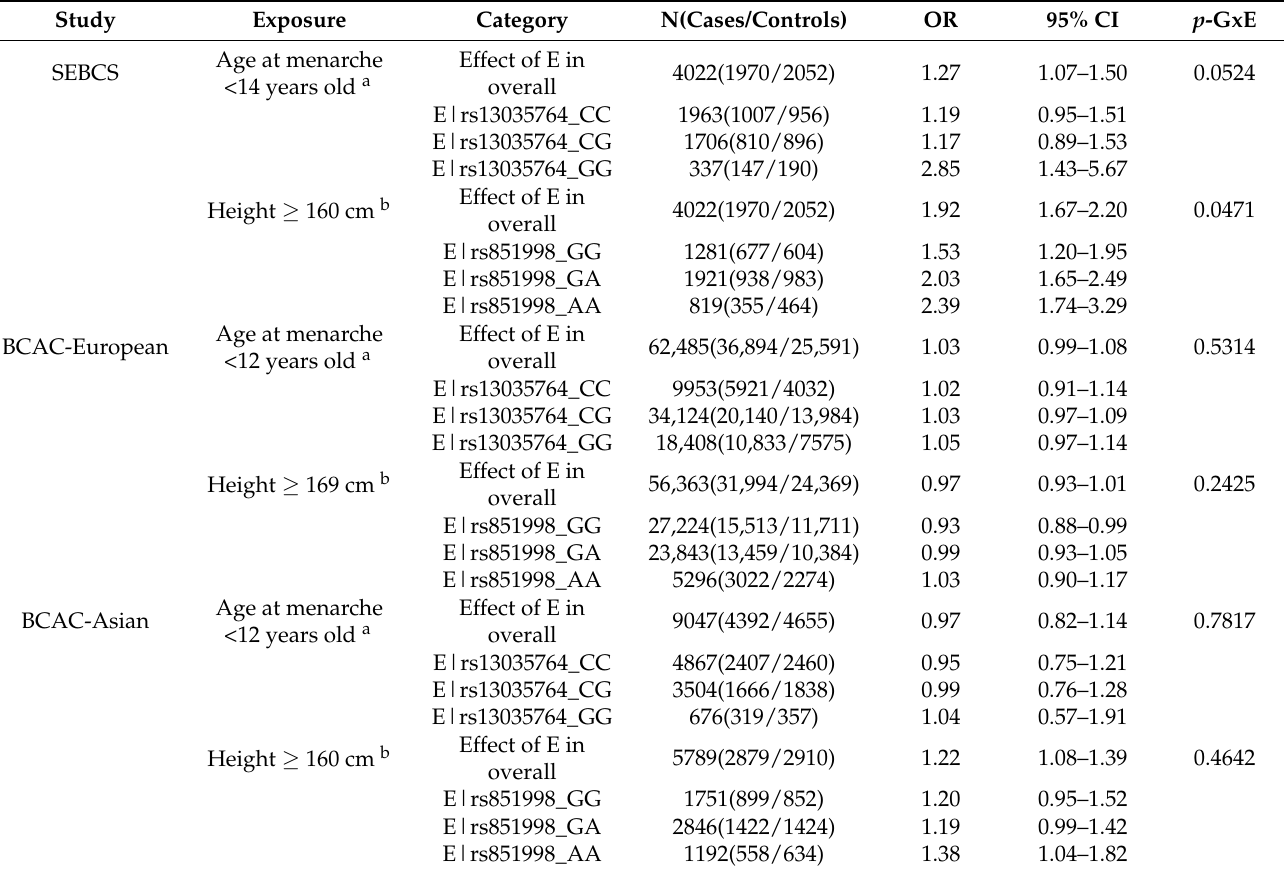
Table 3. Association between an environmental factor and breast cancer by